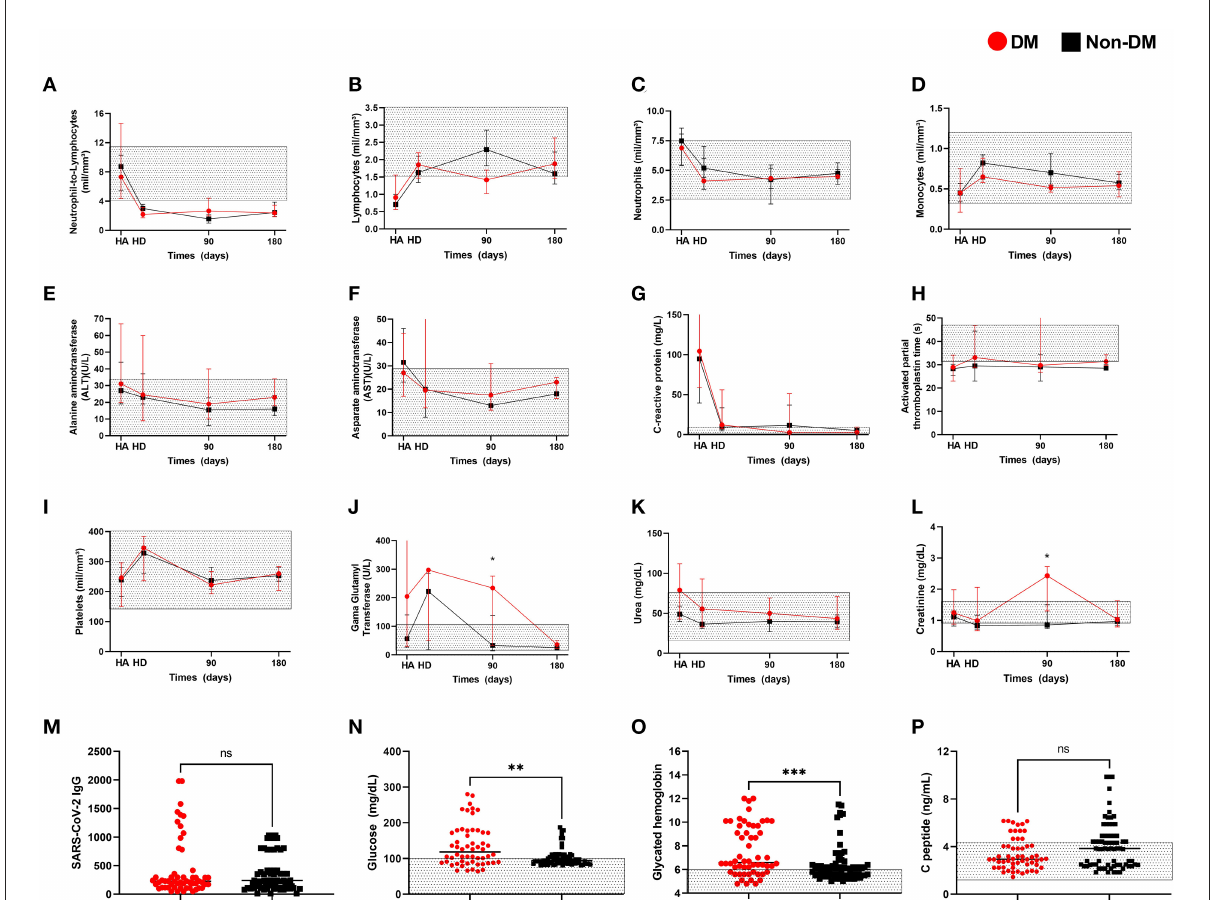
FIGURE1 Laboratory data from Diabetic and non-diabetic COVID-19 from hospital admission, hospital discharge and up to 240 after hospital discharge. Patients’ (A) neutrophil-to-lymphocyte ratio, (B) lymphocytes, (C) neutrophils, (D) monocytes, (E) alanine aminotransferase, (F) aspartate aminotransferase, (G) C-reactive protein, (H) activated partial thromboplastin time, (I) platelets, (J) gama glutamyl transferase, (K) urea, (L) creatinine from first hospitalization day, hospital discharge and monthly evaluations after SARS-CoV-2 clearance and hospital discharge. (M) anti-SARS-CoV-2 IgG, (N) fasting blood glucose, (O) glycated hemoglobin, (P) peptide C test from patients over 180 days after hospital discharge. * p < 0.05. Non-parametric Mann-Whitney test was used for